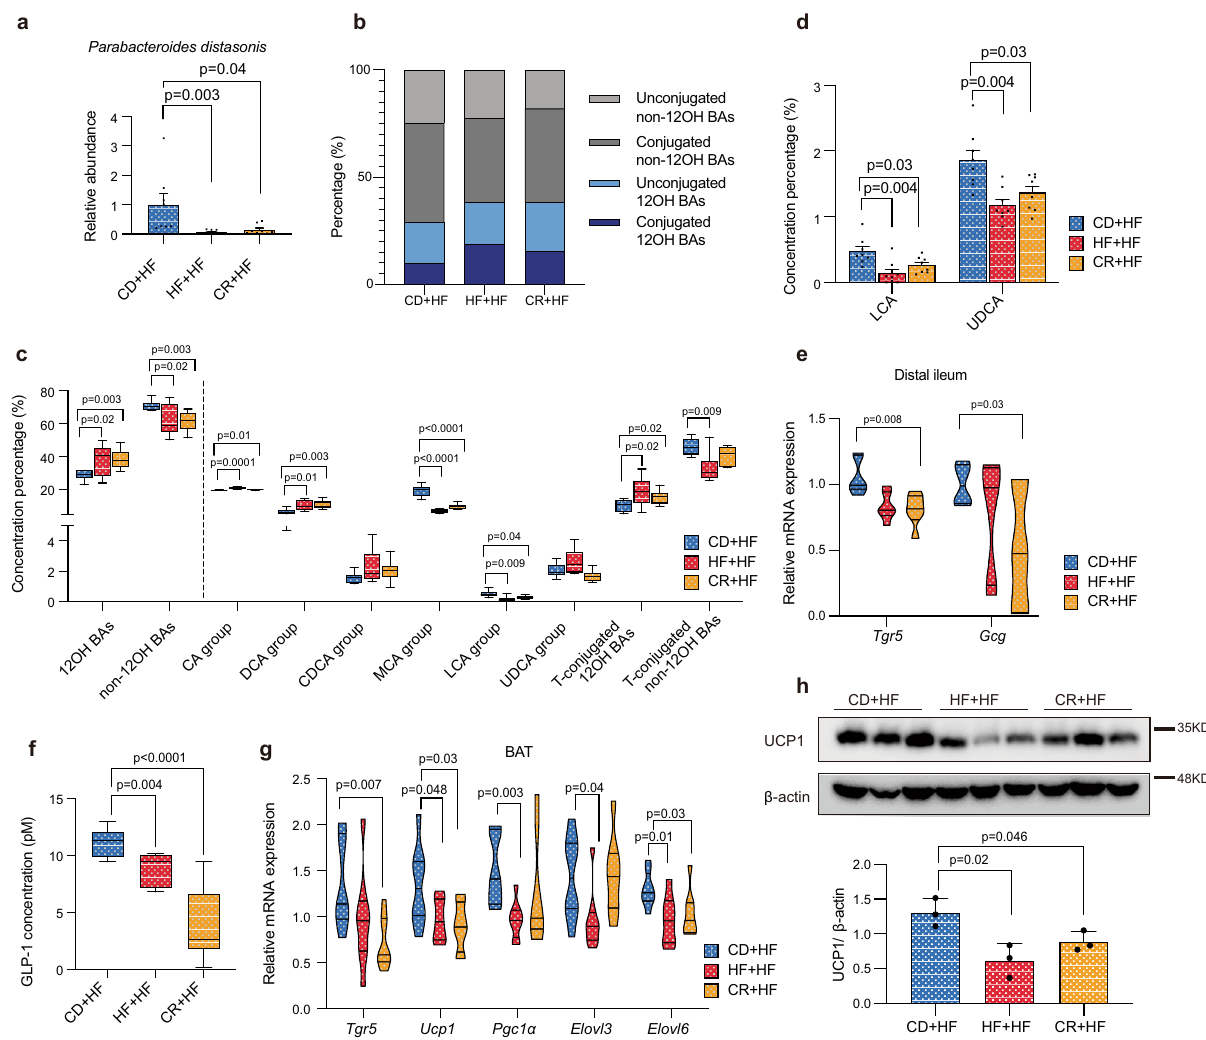
Fig. 5 The depletion of Parabacteroides distasonis and non-12OH BAs resulted in reduced energy expenditure in the weight-rebound mice. a Relative abundance of Parabacteroides distasonis in the contents of cecum among three groups. b The (un)conjugated (non-)12OH BAs percentage in the serum. c The BAs composition pro fi les in the serum. p -values were adjusted by the FDR ’ s method. d The composition level of LCA and UDCA in the serum. p - values were adjusted by the FDR ’ s method. e Relative mRNA expression of Tgr5 and Gcg genes in the distal ileum, n = 6 per group. f Active GLP-1 level in serum. g Relative mRNA expression of thermogenesis-related genes in the BAT. h UCP1 protein expression in the BAT, n = 3 per group. n = 8 per group in the experiments. Differences were assessed by a two-tailed multiple T-test in the GraphPad software. Data were expressed as means ± SEM in the bar plots. All box and whiskers plots showed the box (from the 25th to 75th percentiles), the median value (in the transverse line), and the whiskers (go down to the smallest value and up to the largest). Source data are provided as a Source data fi le. 12 α -hydroxylated bile acids (12OH BAs); non-12 α -hydroxylated bile acids (non-12OH BAs); T-conjugated (taurine-conjugated); cholic acid (CA); deoxycholic acid (DCA); chenodeoxycholic acid (CDCA); muricholic acid (MCA); lithocholic acid (LCA); ursodeoxycholic acid (UDCA); Takeda G protein-coupled receptor 5 ( Tgr5 ); glucagon-like peptide-1 (GLP-1); brown adipose tissue (BAT); uncoupling protein 1 ( Ucp1 ); peroxisome proliferator-activated receptor- γ coactivator-1 α ( Pgc1 α ); elongation of very long-chain fatty acids 3 ( Elovl3 ); elongation of very long-chain fatty acids 6 ( Elovl6